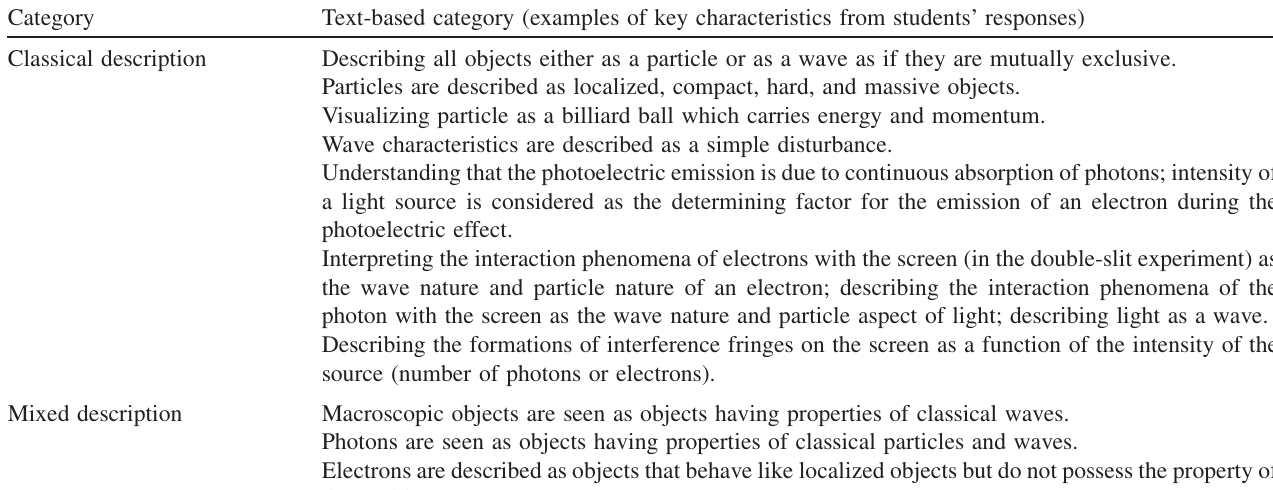
TABLE II. Students’ depiction of concept 1: wave-particle duality. Category Text-based category (examples of key characteristics from students’ responses) Classical